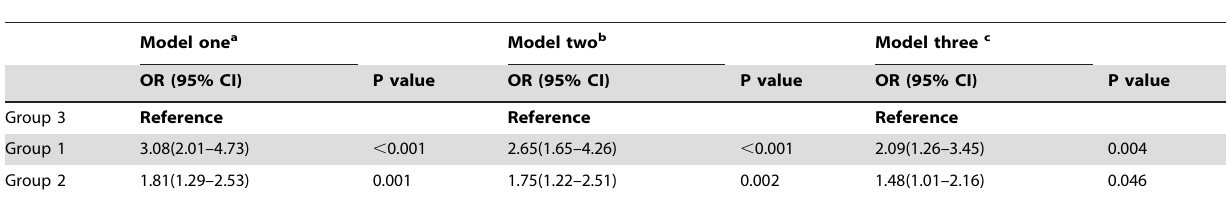
Table 2. Association of the hypertriglyceridemic waist phenotype with